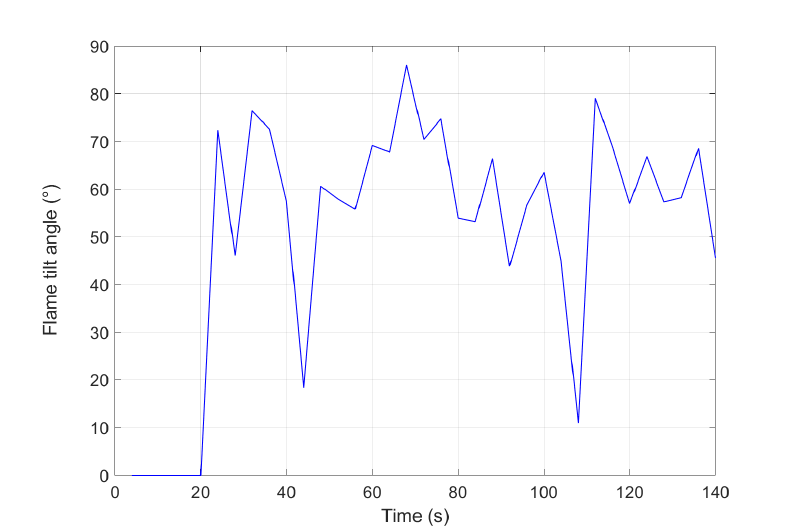
Figure 35. Temporal evolution of the flame tilt